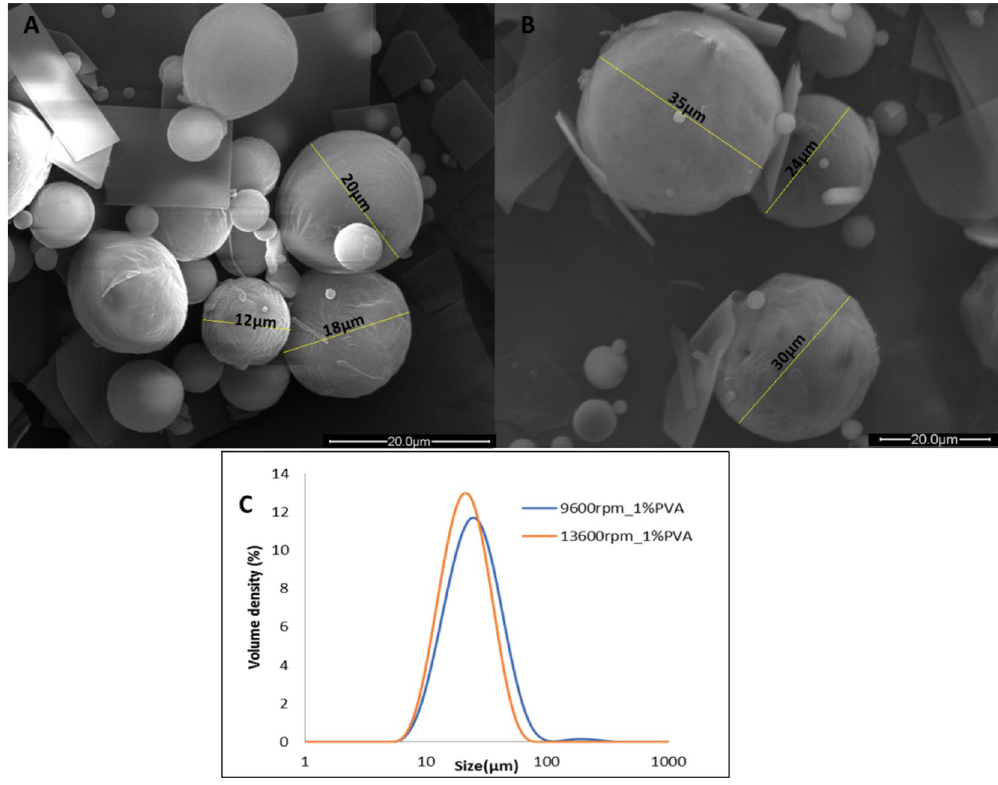
Figure 4. SEM images of PCL microparticles produced with two different homogenization speeds: ( A ) 9600 rpm and ( B ) 13,600 rpm. ( C ) Mastersizer data of the mean microparticle size with two different homogenization